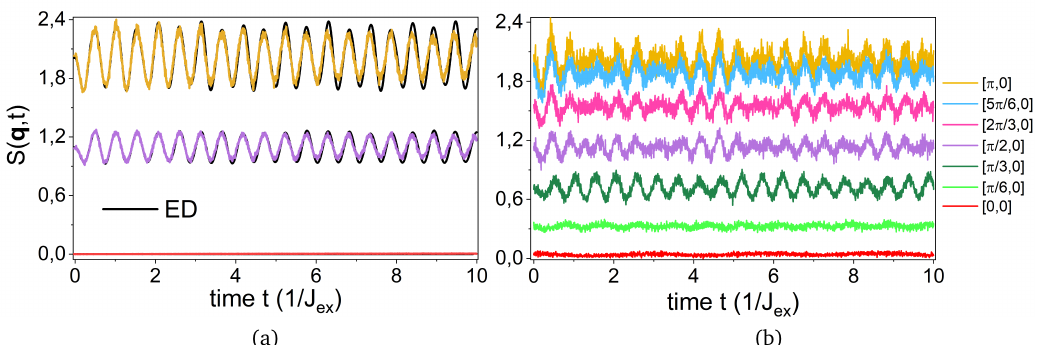
Figure 3: (a) Dynamics of the structure factor for L = 4, α = 10. Excellent agreement with ED (solid black line) is found. (b) Similar dynamics for L = 12, α = 8. In both cases all the non-equivalent modes q = [ q ,0 ] in the first Brillouin zone are plotted. Note that the number of such modes depends on the system size. The noise in (b) is due to a limited Monte Carlo sampling.